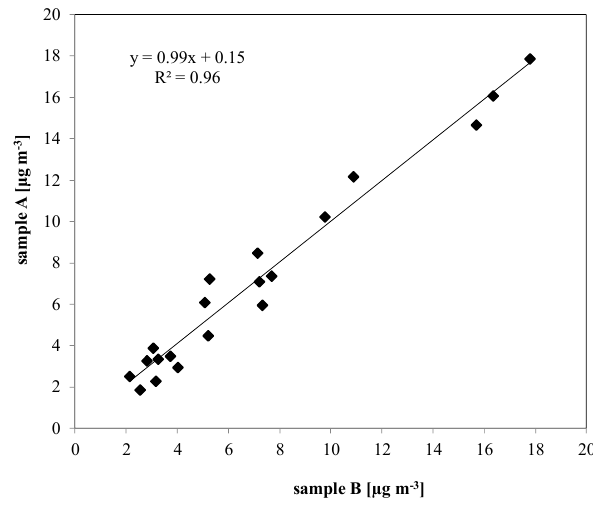
Fig. 5. Scatter plot of the water content of PM 10 samples collected side-by-side (20